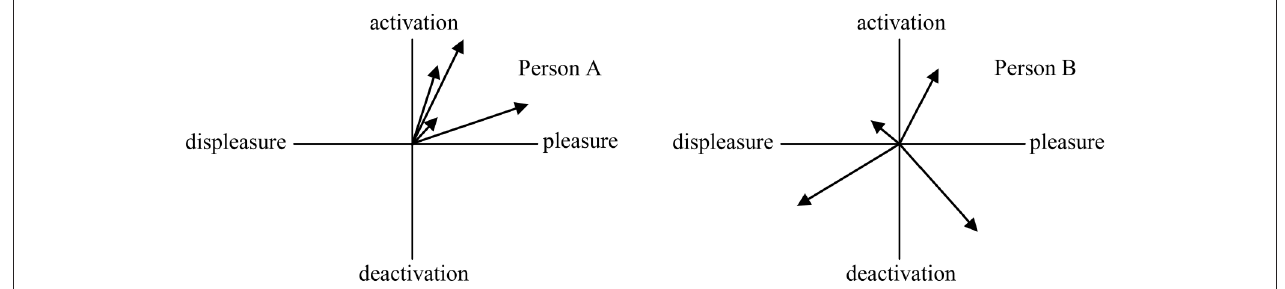
FIGURE 3 | Illustration of affect spin using two hypothetical